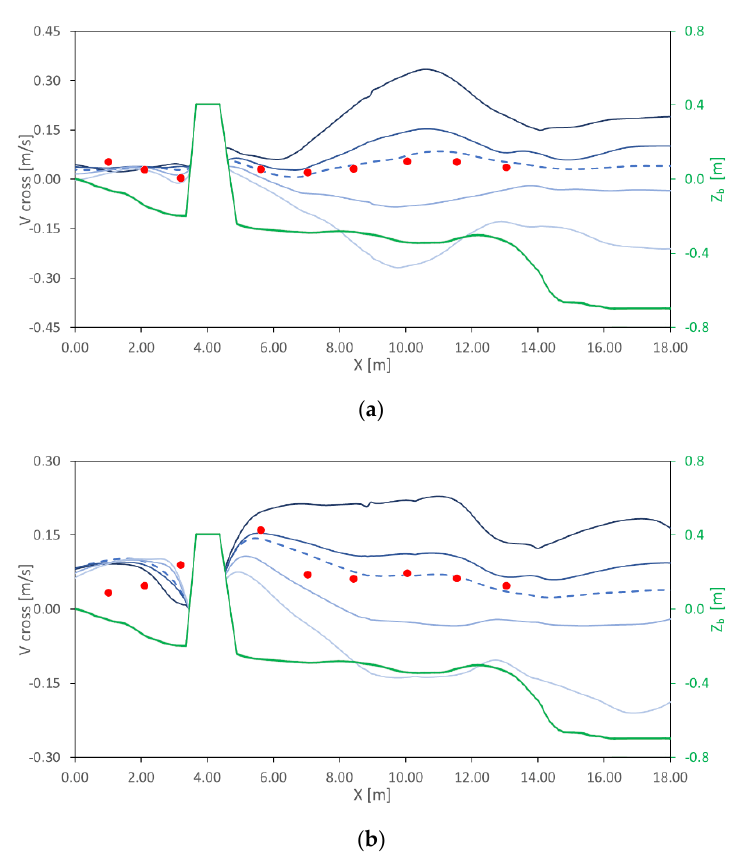
Figure 11. Cross-shore currents at Y = 22 m ( a ) and Y = 26 m ( b ). Dashed blue line: depth-averaged velocity field computed by the proposed model. Solid blue lines: velocity fields computed by the proposed model at relative position from free-surface z / z b = 0.133, z / z b = 0.400, z / z b = 0.667, z / z b = 0.933, from lightest blue to darkest blue. Red circles: experimental results obtained by Gravens and Wang [33]. Green line: bottom elevation.